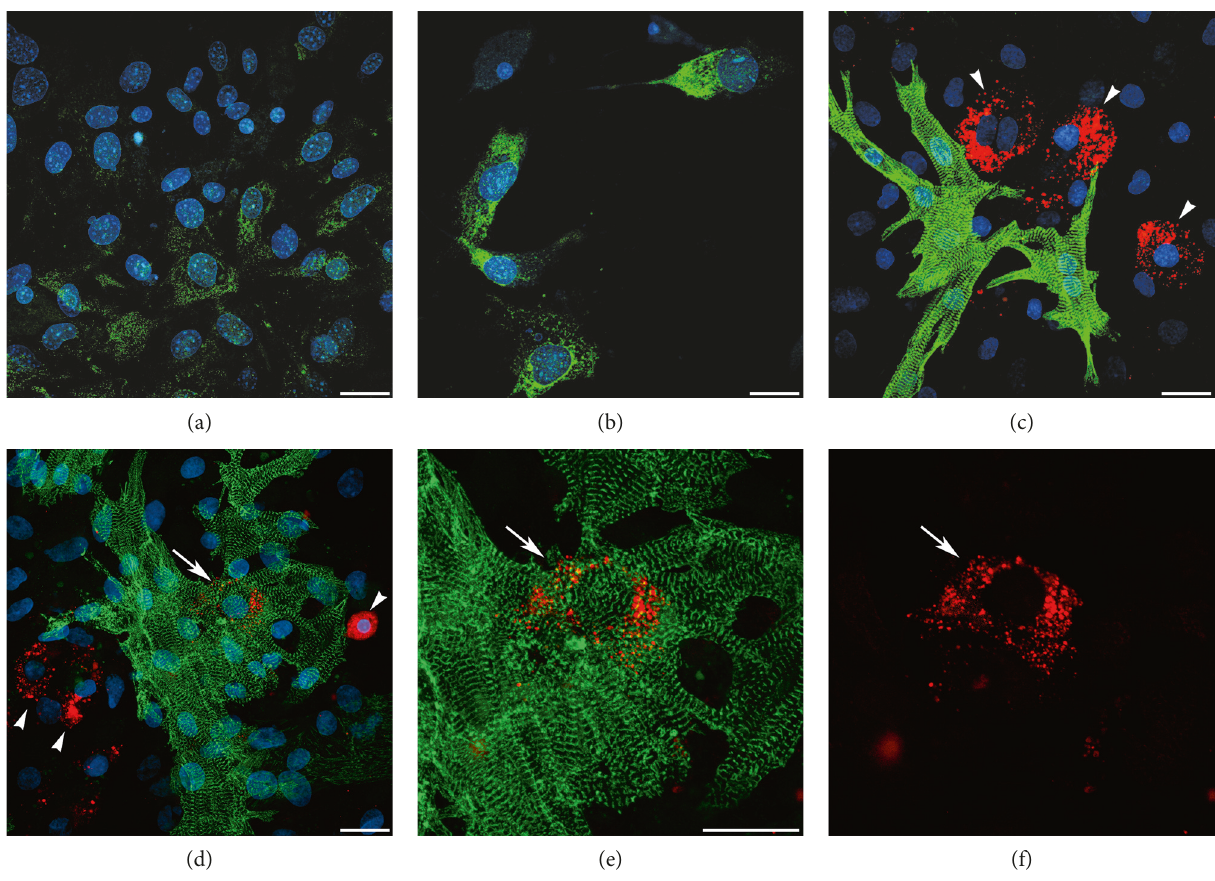
Figure 5: Cardiac di ff erentiation of MSCs following treatment with BIX01294 ± TSA. (a), (b) MSCs were immunostained for titin (green) and DAPI counterstained (blue), after 7 day incubation with Wnt11, following pretreatment with (a) BIX01294 or (b) BIX01294+TSA. (c) – (f) Coculture of CFSE vital dye-labeled MSCs (red) with neonatal rat cardiomyocytes that were immunostained for α -actinin (green) and DAPI counterstained (blue). (c) MSCs that were nontreated prior to coincubation with rat myocytes did not display cardiac phenotypes, as indicated by cells that exhibited only the red vital dye (arrowheads). (d) – (f) In contrast, MSCs pretreated with BIX01294 label showed evidence of cardiac di ff erentiation when in proximity to the rat myocytes. (d) While the majority of MSCs in these later cultures remained nondi ff erentiated, as indicated by the sole display of the red vital dye (arrowheads), individual BIX01294-treated MSCs were observed that exhibited dual red and green fl uorescence (arrow). (e), (f) Higher-magni fi cation view of this coculture shown in the successive panels for both the vital dye fl uorescence and actinin immunostaining or vital dye-label only indicates that the red and green colabeled MSC-derived cell (arrow) exhibits α -actinin in a striated pattern. Scale bar =25 μ